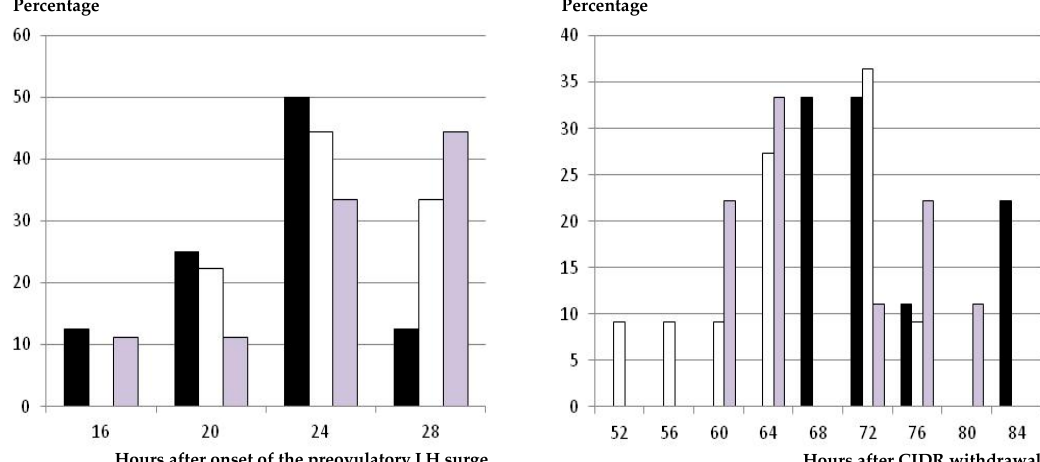
Figure 4. Distribution (percentage of animals) of time of occurrence of ovulation, in hours after onset of the preovulatory LH surge ( left hand ) and after CIDR withdrawal ( right hand ), in ewes treated with a single i.m. dose of 400 IU of eCG at CIDR removal (group CIDR-eCG, white bars), with a single dose of GnRH at 56 h after CIDR removal (group CIDR-GnRH, grey bars), and with two GnRH doses—one at CIDR insertion and one 56 h after CIDR removal (group GnRH-CIDR-GnRH, black bars).